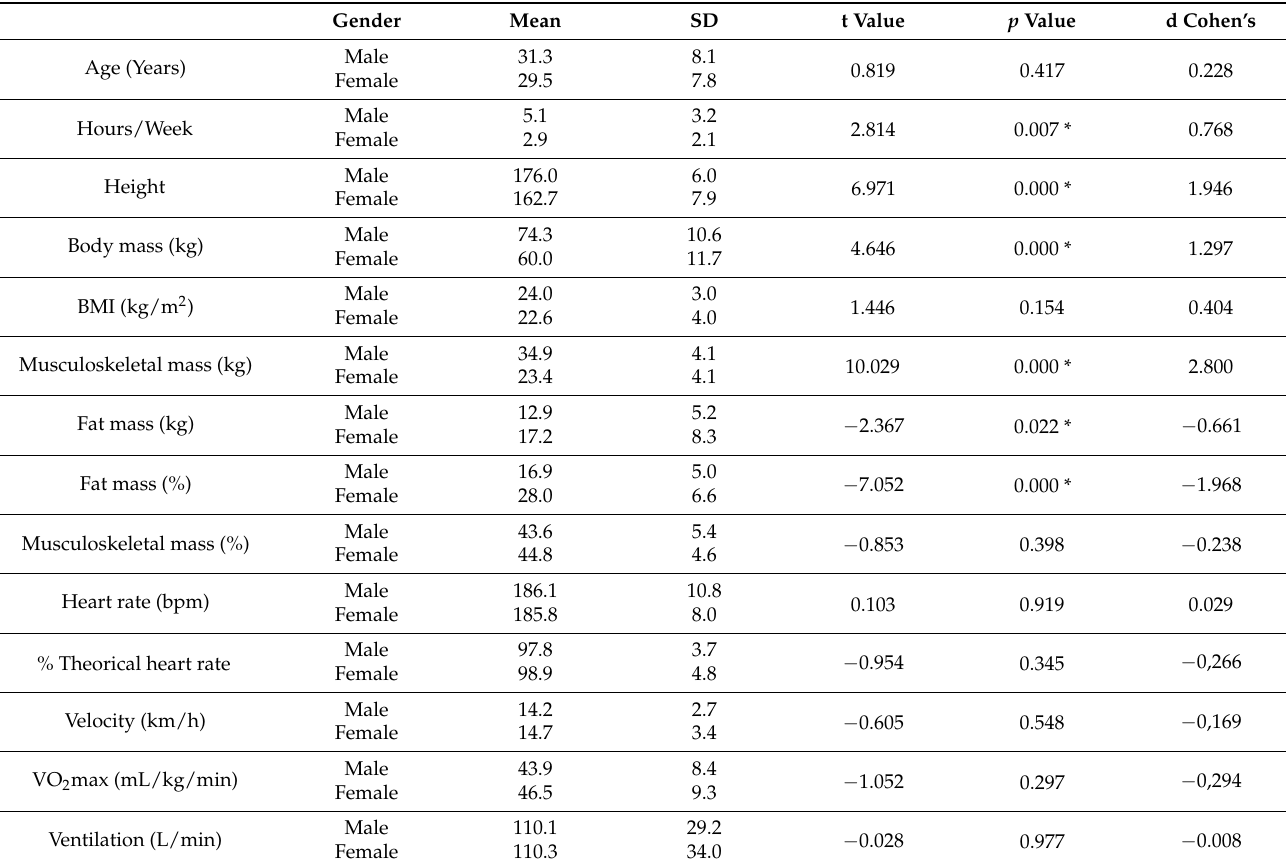
Table 2. Comparison between sexes of the basic characteristics of the population, and of the maximum values of the stress test (males = 33; females n =